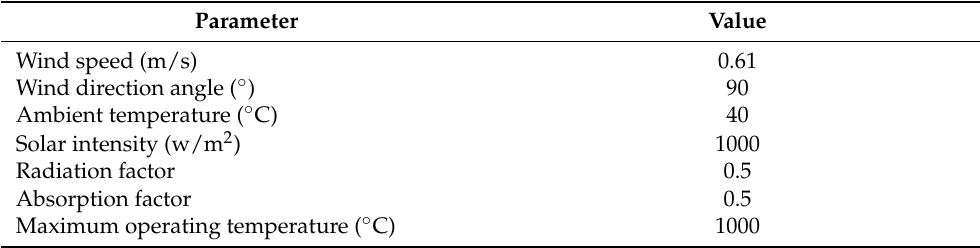
Table 4. Limits of the static rating.